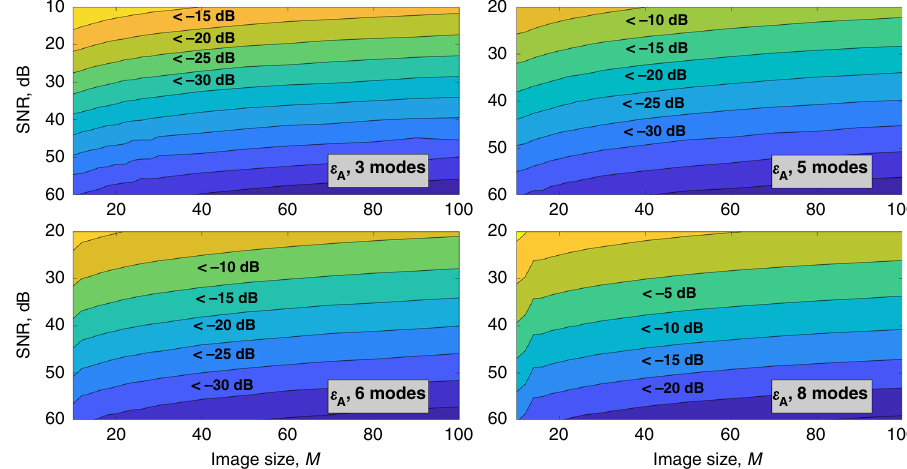
Fig. 5 Dependence of the amplitude decomposition error on noise level and image size. Amplitude decomposition error ε A for a 3-mode, b 5-mode, c 6- mode, and d 8-mode fi bers depending on image size and noise level in the input image. Horizontal axes correspond to the image size in pixels, vertical axes correspond to SNR value in dB. Amplitude decomposition error values are color-coded, regions with an error value less than a certain value are labeled on the graphs. Source data are provided as a Source Data fi